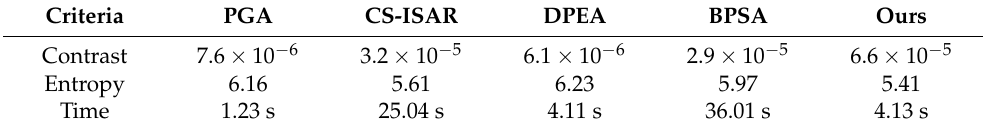
Table 2. Simulated trajectory error parameters.